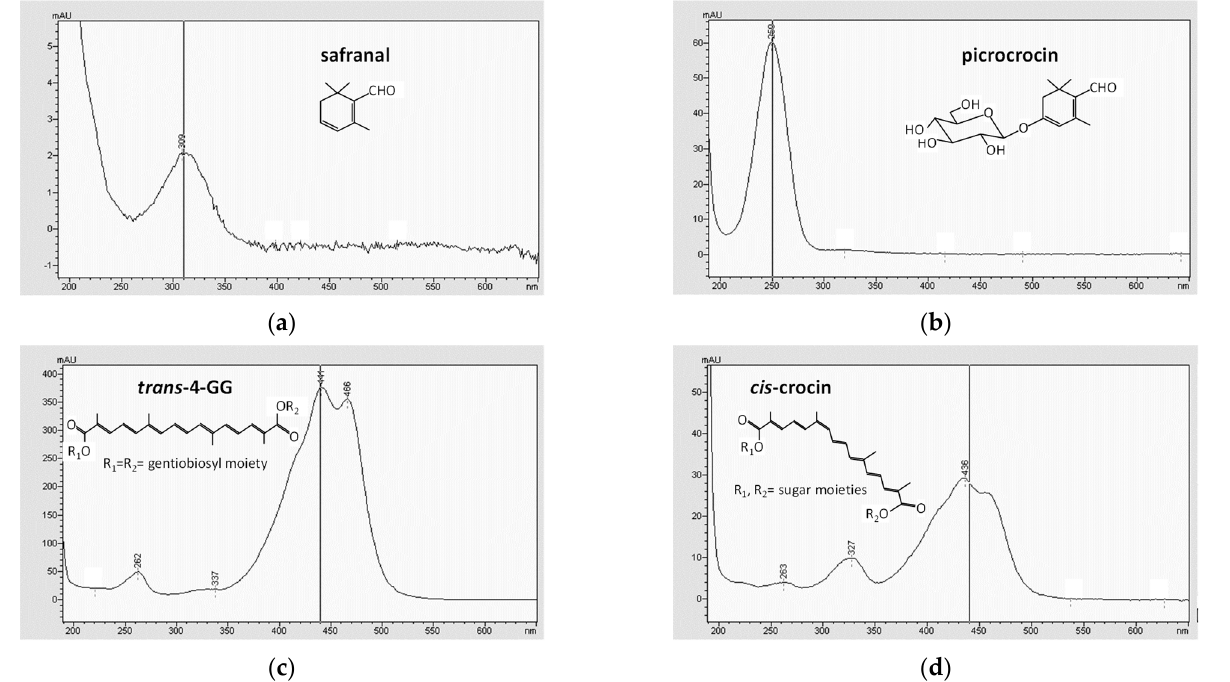
Figure 2. UV–Vis absorption spectra and chemical structures of saffron bioactive compounds: ( a ) safranal, ( b ) picrocrocin, ( c ) trans ‐ 4 ‐ GG, and ( d ) cis ‐ crocin. All analytes were dissolved in methanol:water (80:20, v / v ).